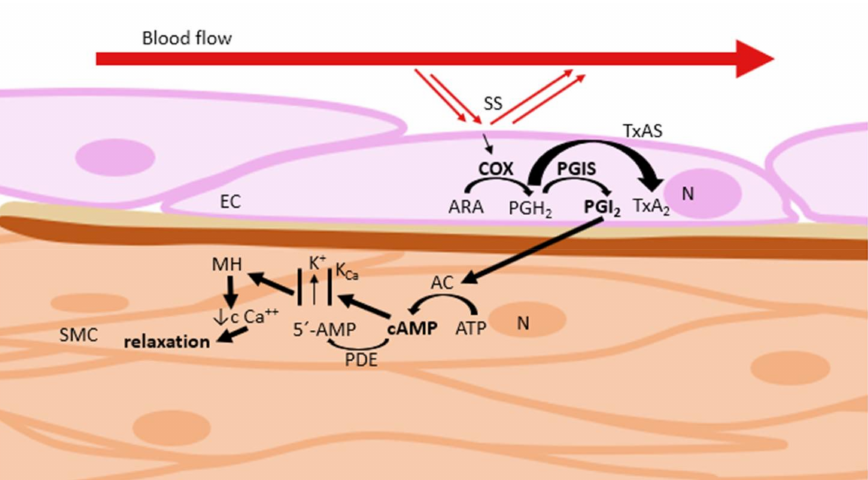
Figure 6. Regulation of vascular tone via prostacyclin–cyclic adenosine monophosphate